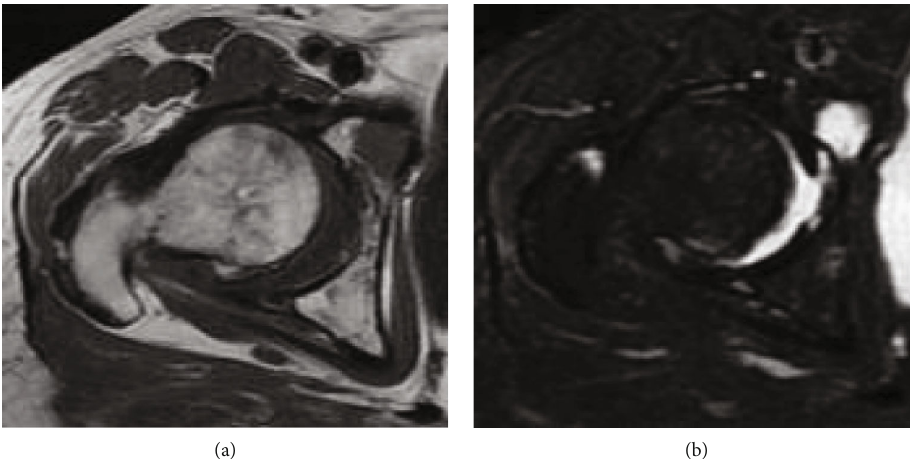
Figure 3: Nonenhanced (a) T1-weighted image and (b) T2-weighted image magnetic resonance image reveals multiple intraosseous lesions in the periacetabular region. There are no periacetabular pathologic fractures.